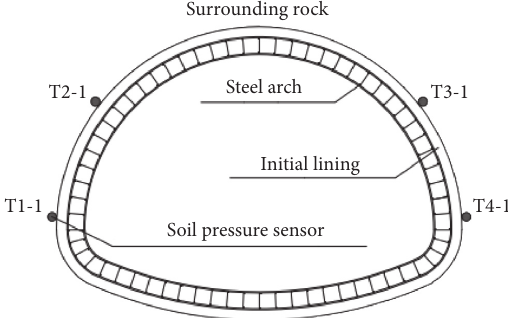
Figure 36: Location of soil pressure sensors.